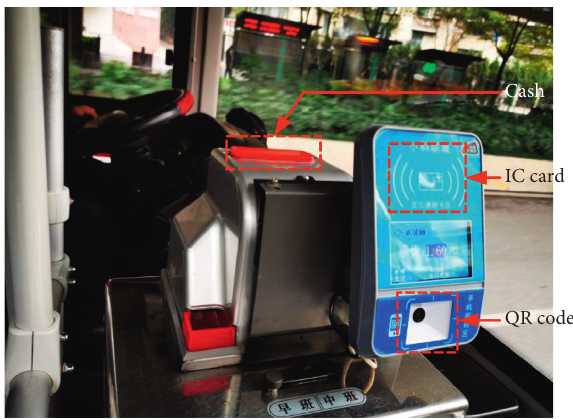
Figure 1: The fare collection methods of the bus transit system in